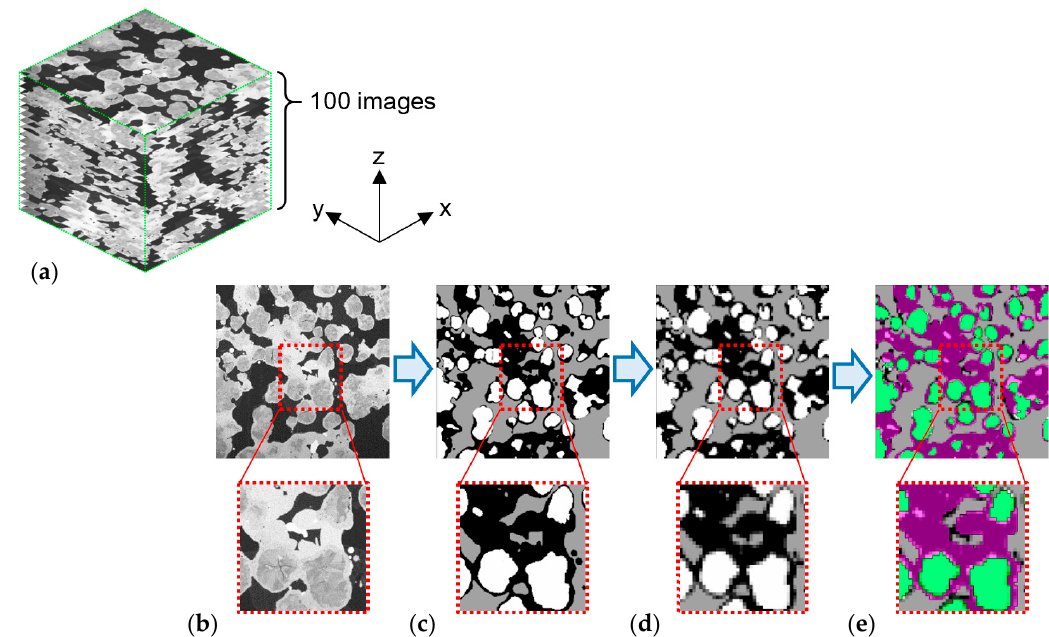
Figure 1. Segmentation flow of the copper- intermetallic compound-resin (Cu-IMC-resin) microstructure composed of Cu, Cu-Sn IMC, and polyimide (PI) resin. ( a ) Schematic of stacked SEM images, ( b ) preprocessed SEM image, ( c ) Otsu segmentation of the image, ( d ) image after Gaussian smoothing, and ( e ) resegmentated image.